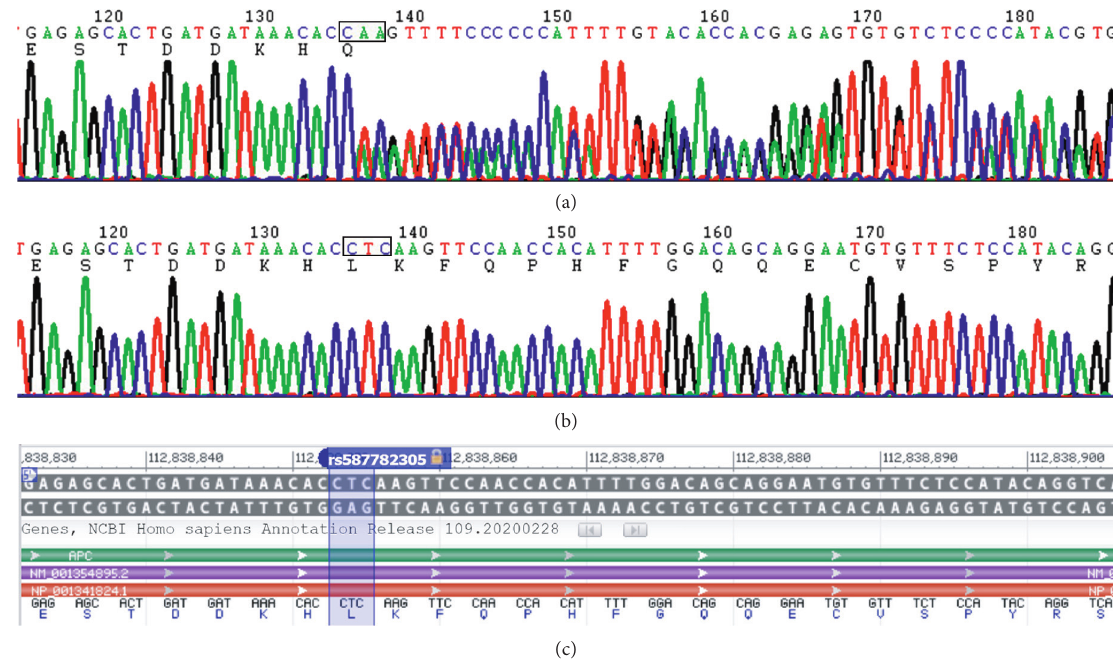
Figure 3: In the FAP family pedigree, a heterozygous deletion was observed in exon 16 of the APC (NM_000038.6): c.3260_3261del: p.(Leu1087Glnfs ∗ 31). Deletion of two bases (TC) causing a frame shift (a), b is the wild type, and c is the corresponding schematic diagram of genomic regions, transcripts, and